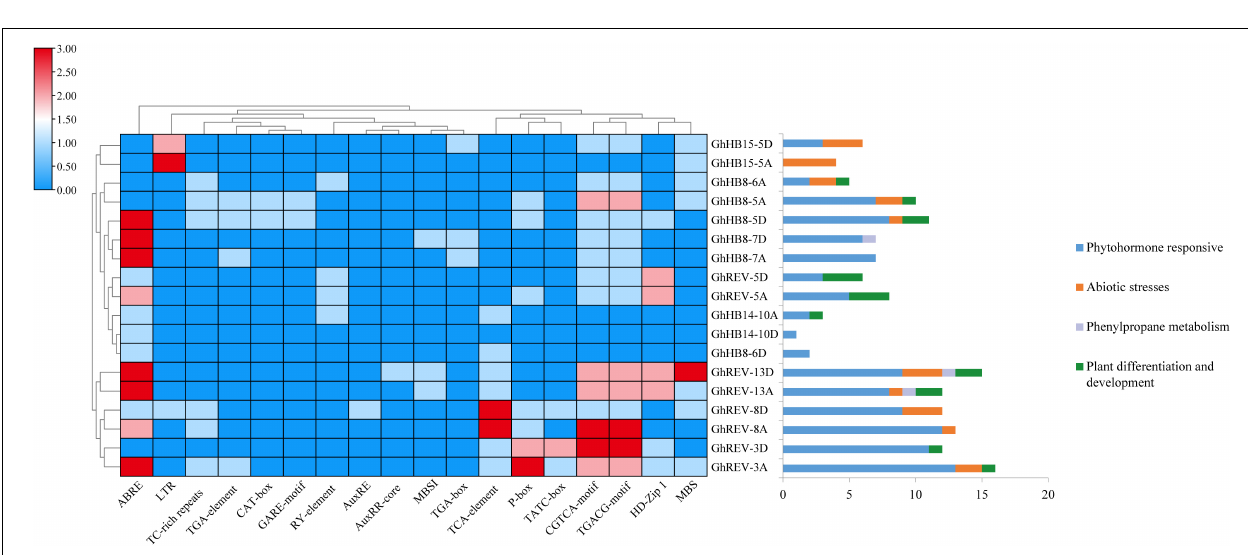
FIGURE 1 | Gene structure and conserved motifs of HD-ZIP III subfamily in cotton ( Gossypium hirsutum ). (A) The exon/intron distribution of HD-ZIP III genes. Green boxes and black lines represent exons and introns, respectively. (B) Conserved motifs of each HD-ZIP III protein. Each conserved motif is indicated by different color boxes. The length of each gene and protein can be estimated using the scale at the bottom.